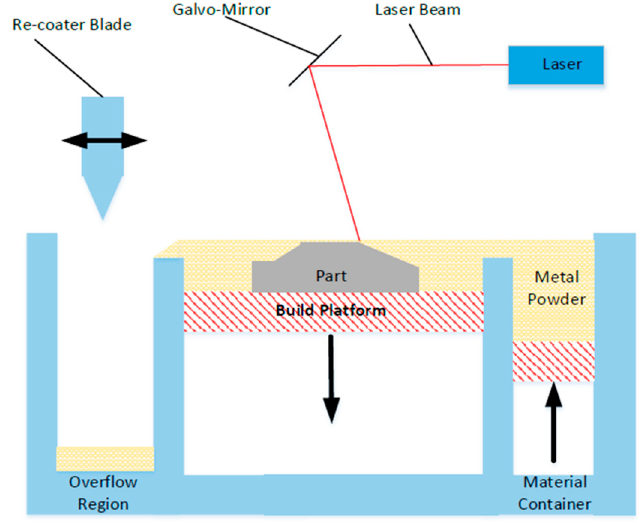
Figure 1. Laser Powder Bed Fusion (L-PBF) process.